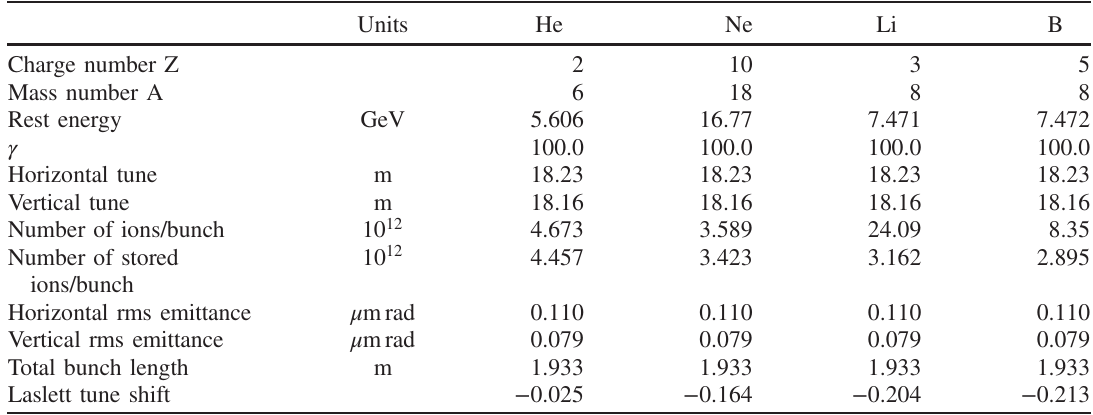
TABLE XIII. Laslett tune shifts for the different ion species in the decay ring.